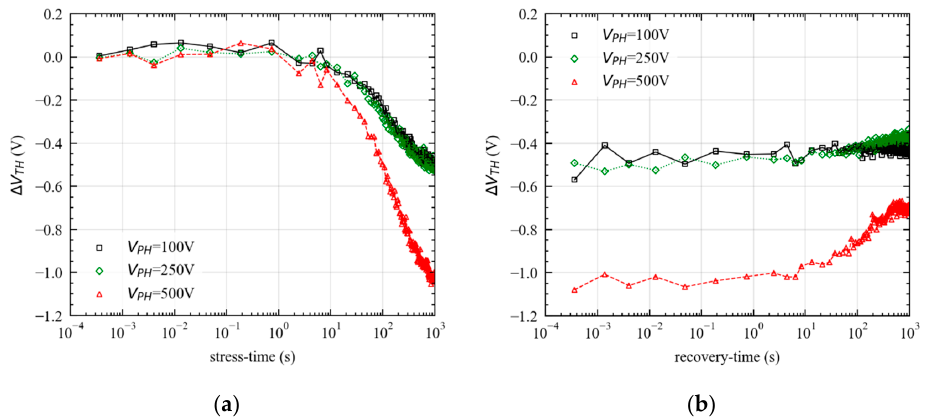
Figure 12. ( a ) Effect of drain off-state stress voltage (100 V, 250 V, and 500 V) on the V TH drift during the stress with V GH = 15 V. At V PH = 500 V, the negative V TH drift retained after 1000 s increases. ( b ) Monitored V TH recovery at different drain stress voltages.